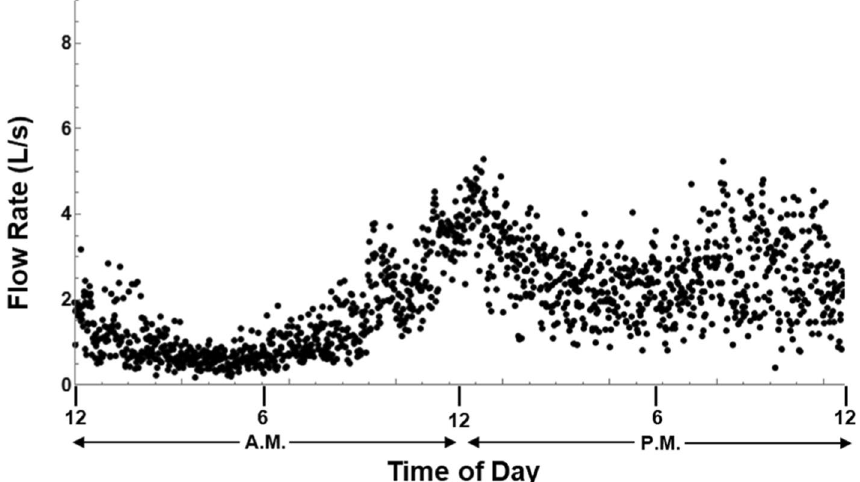
Fig. 12 Thursday average readings for daily